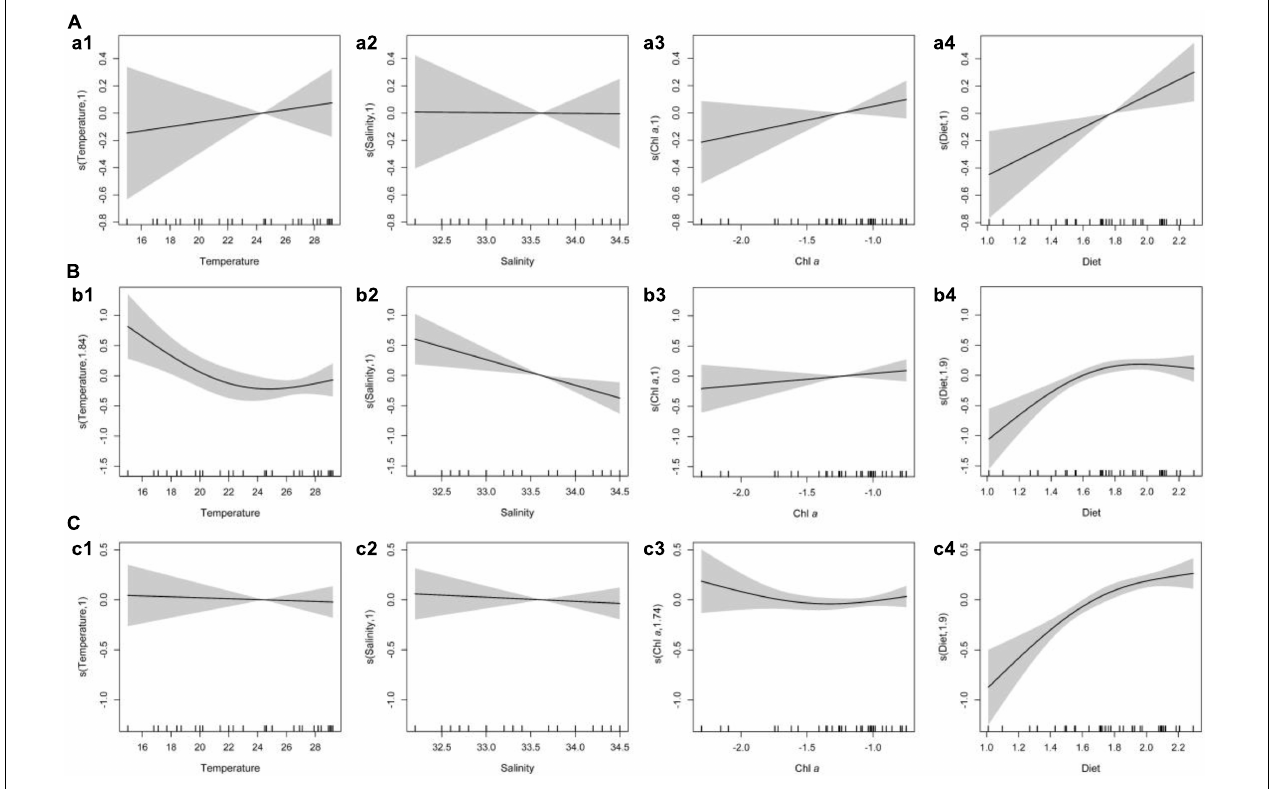
FIGURE 6 | Generalized additive model analysis results for the abundance of medusae and environmental factors. [ (A) holoplanktonic hydromedusae; (B) meroplanktonic hydromedusae; (C) siphonophore].